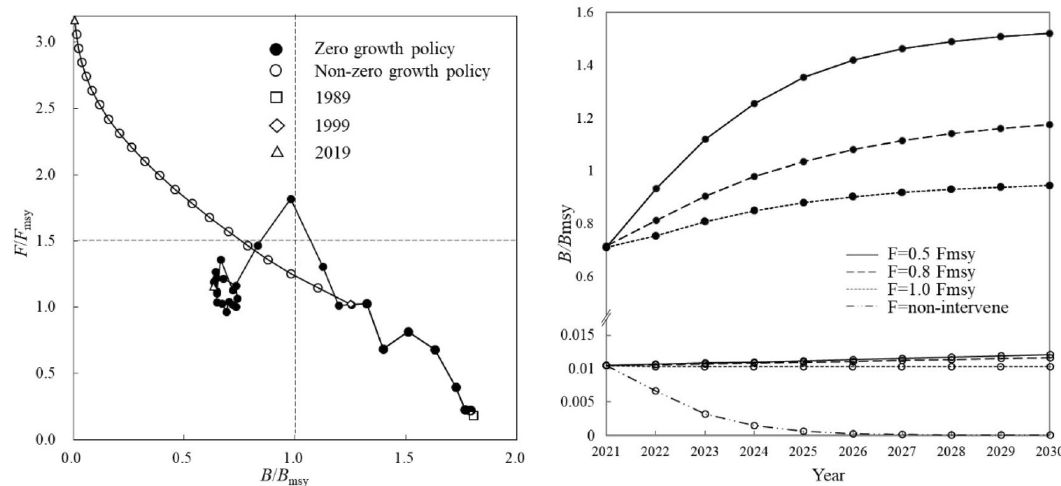
Figure 10. Rebuilding status of the cuttlefishes. Resource status in different quadrants following explanation in Fig.